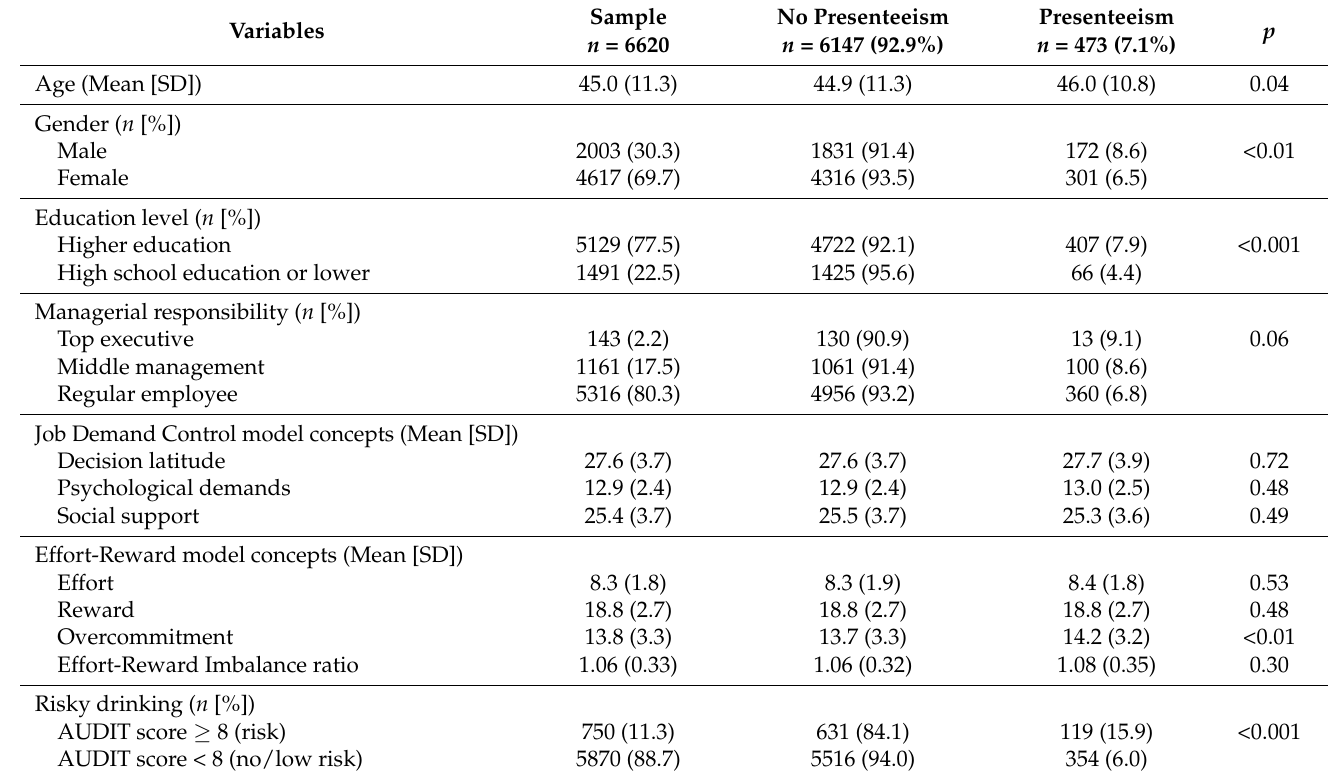
Table 1. Characteristics of the study sample and comparisons between participants reporting presenteeism versus no presenteeism.